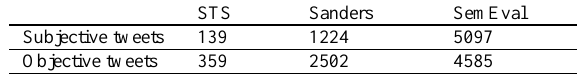
Table 1. Labels of dataset records.